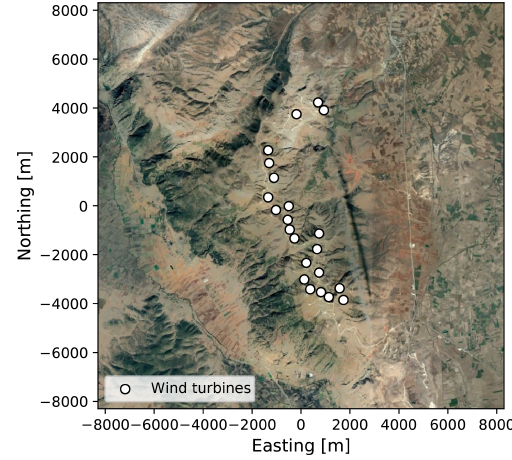
Figure 14. The aerial image of the Turkish site. Aerial data: © Google Maps, DigitalGlobe.